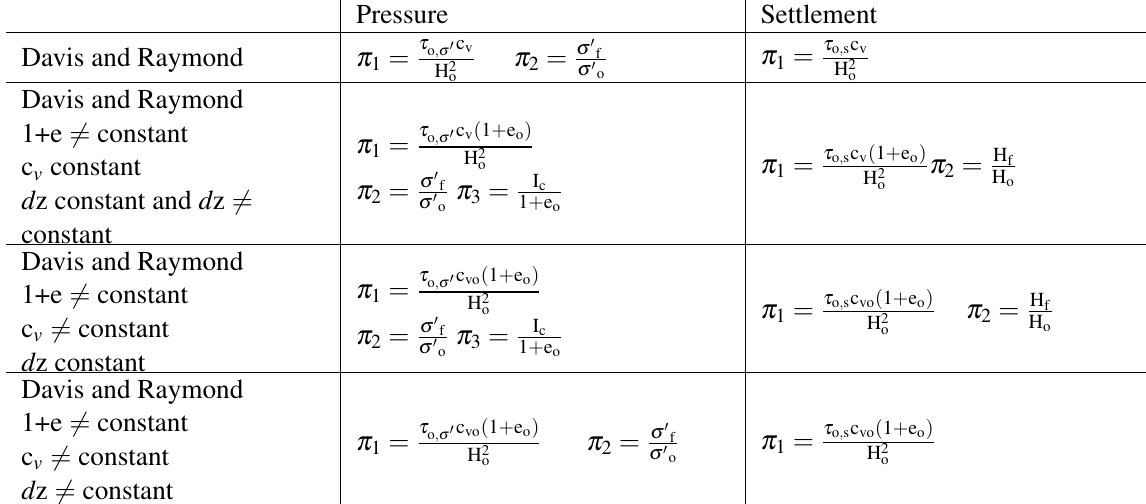
Table 2 Dimensionless groups that characterize the solutions for the different variants of the Davis and Raymond model